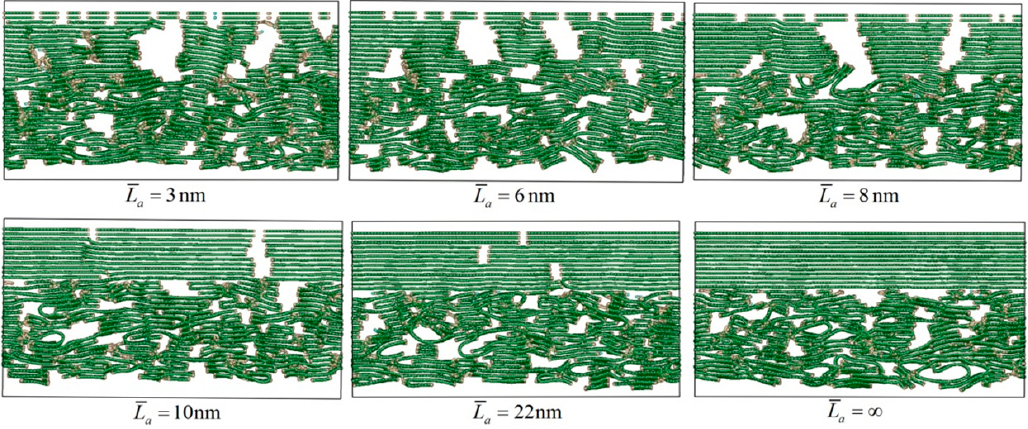
Figure 3. Typical C f /PyC interphase models with different sizes of L a